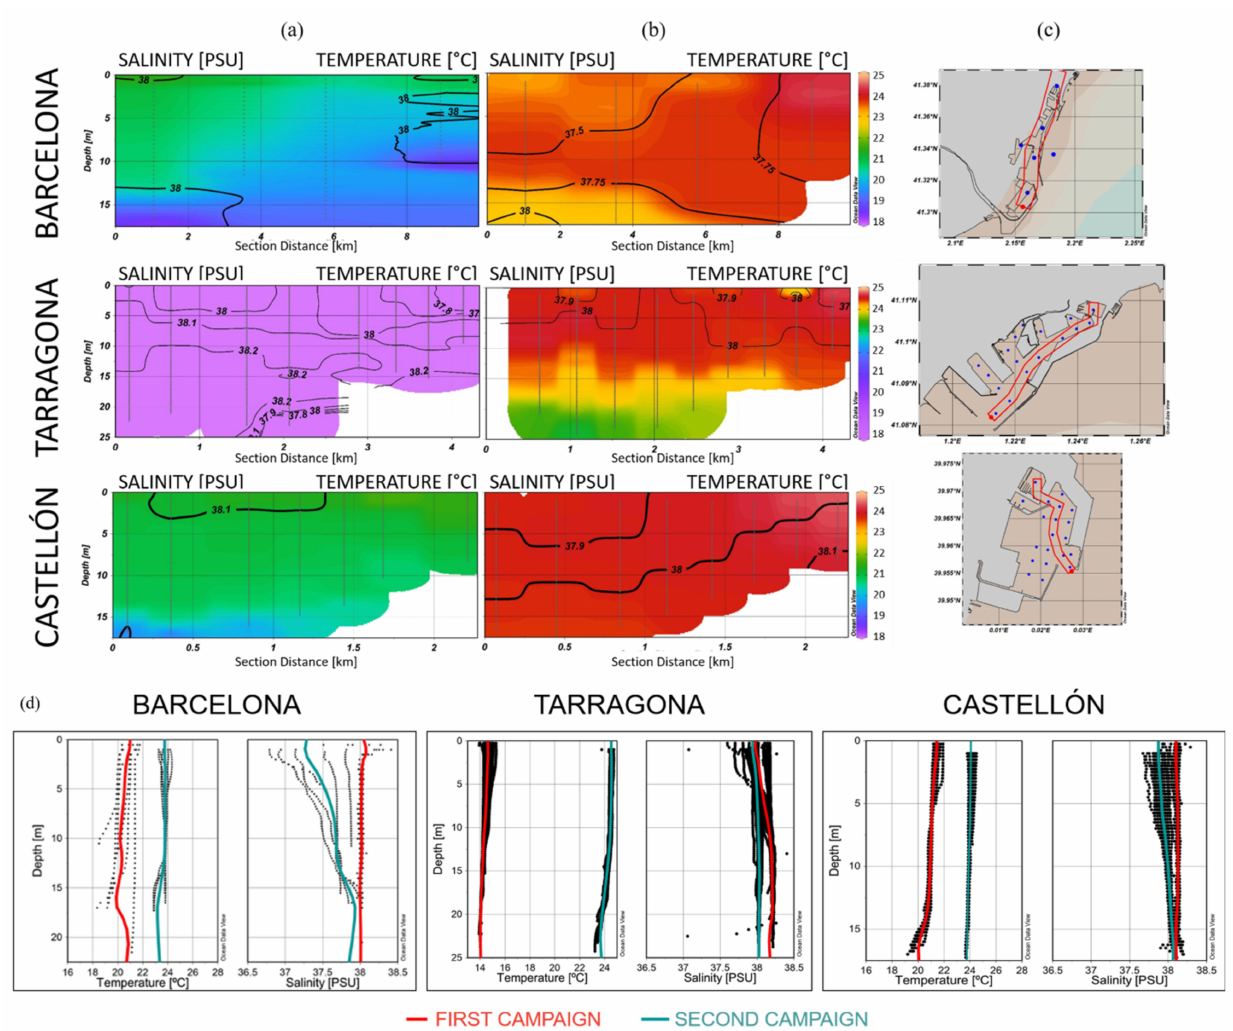
Figure 6. Temperature ( ◦ C) and salinity (PSU) sections (columns ( a ) and ( b )) and profiles in Barcelona, Tarragona, and Castell ó n harbours (line d ). In the presented sections, the colour bar shows tempera- ture values and black lines show salinity values. Profiles in red correspond to the average of the first campaign’s data, while profiles in blue correspond to the average of the last campaign’s data. ( c ) is the location of the analysed